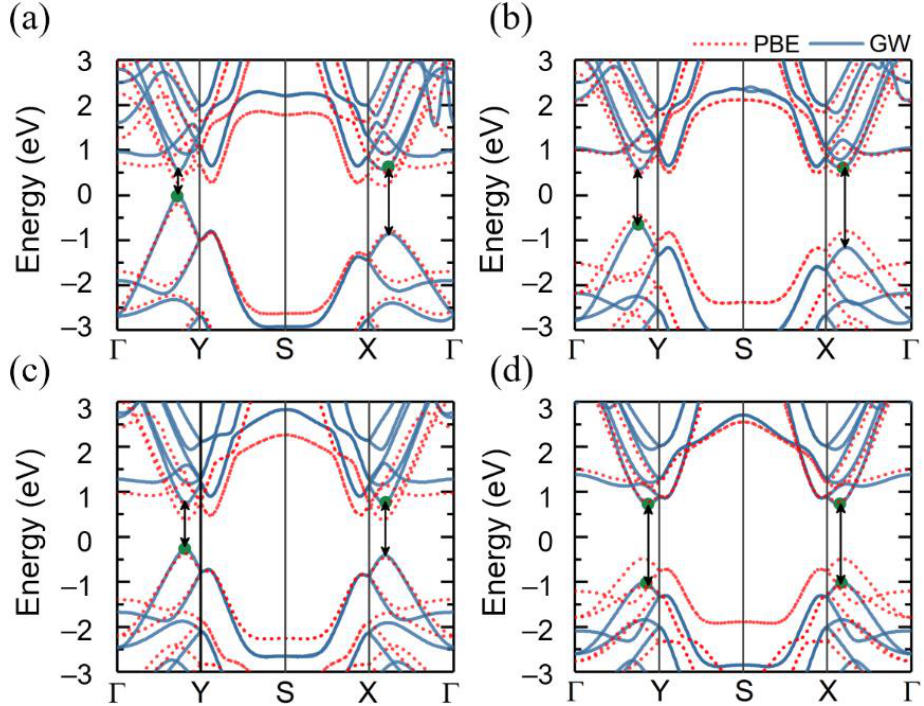
Figure 2. Calculated band structures as obtained from the PBE functional (red dotted lines) and from the GW method (blue lines) for monolayers ( a ) SiTe ( b ) GeTe ( c ) SnTe ( d ) PbTe. Green circles indicate the global CBM or VBM. Local direct transitions are indicated by arrows.